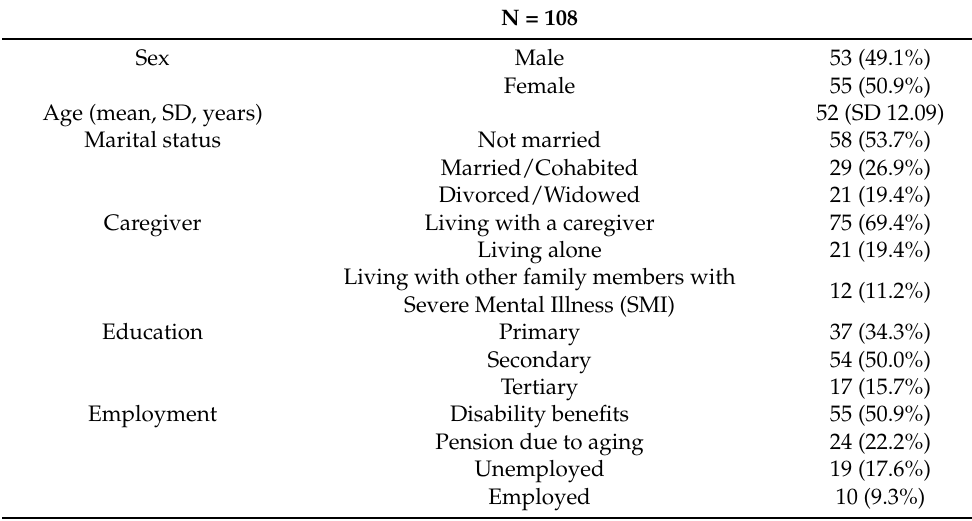
Table 1. Patients’ demographic characteristics.